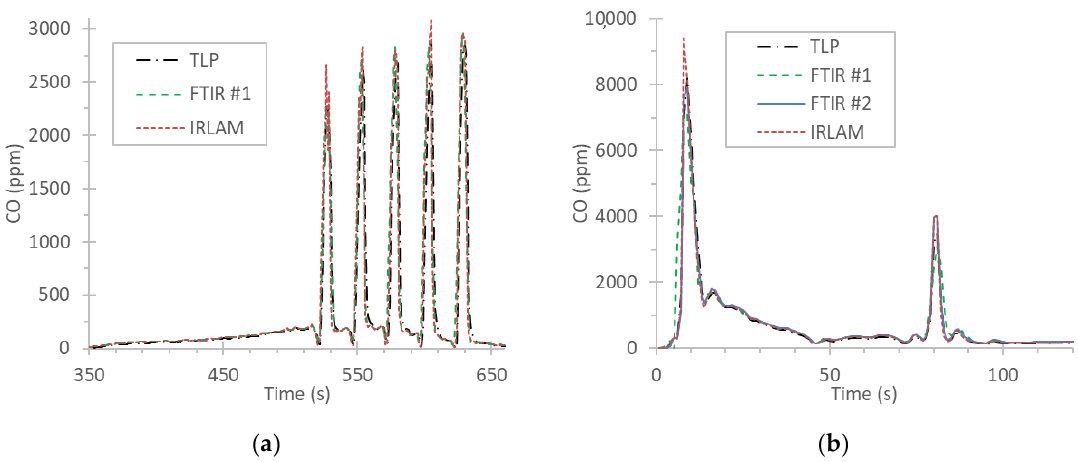
( b ) Figure 2. Real time CO 2 tailpipe concentrations during: ( a ) a cold start WLTC of the gasoline Euro 4 (G4) vehicle; ( b ) steady 130 km/h test with regeneration of the Diesel Euro 6 (D6) vehicle. Figure 3a plots CO concentrations of the D6 vehicle during the DPF regeneration at 130 km/h. The emissions ranged from 0 ppm up to 3000 ppm. The agreement of the in-